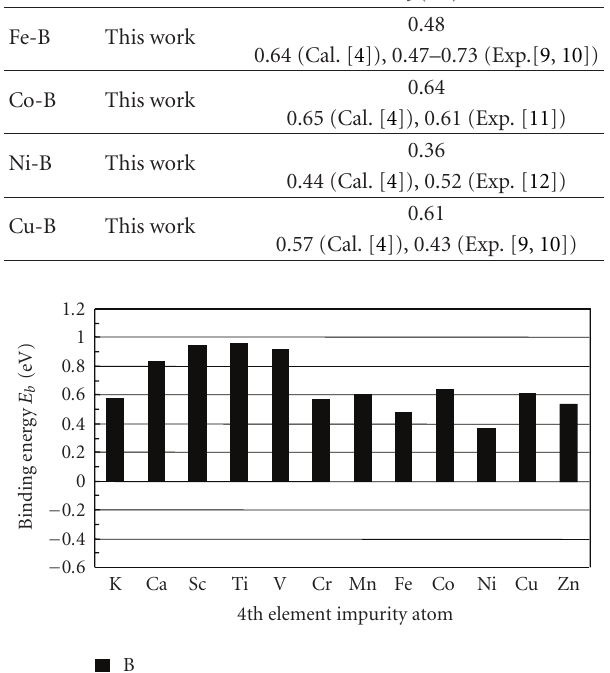
Figure 2: Calculated binding energy E b of B to 4th element impurity